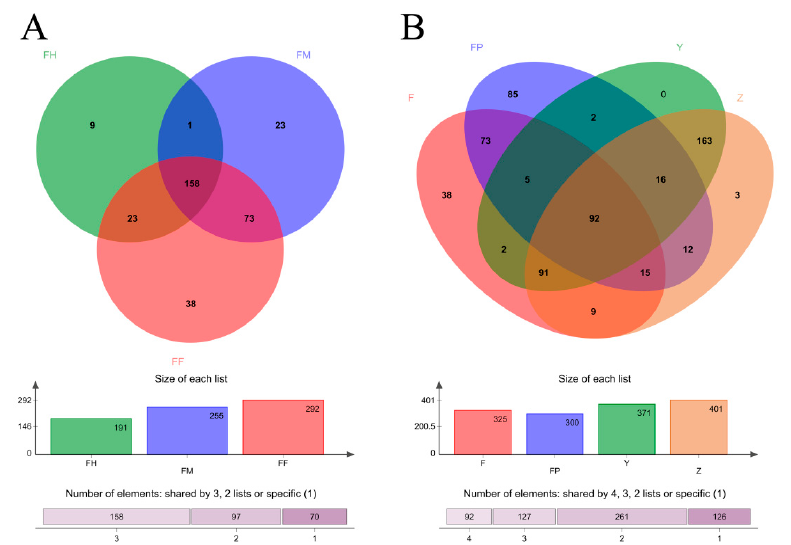
Figure 4. Venn diagrams of shared OTUs among different sample groups. ( A ) Venn diagrams of shared OTUs among the three intestinal segments of larvae. ( B ) Venn diagrams of shared OTUs among larval guts, pupal guts, pupal chamber tissues, and larval gallery tissues.